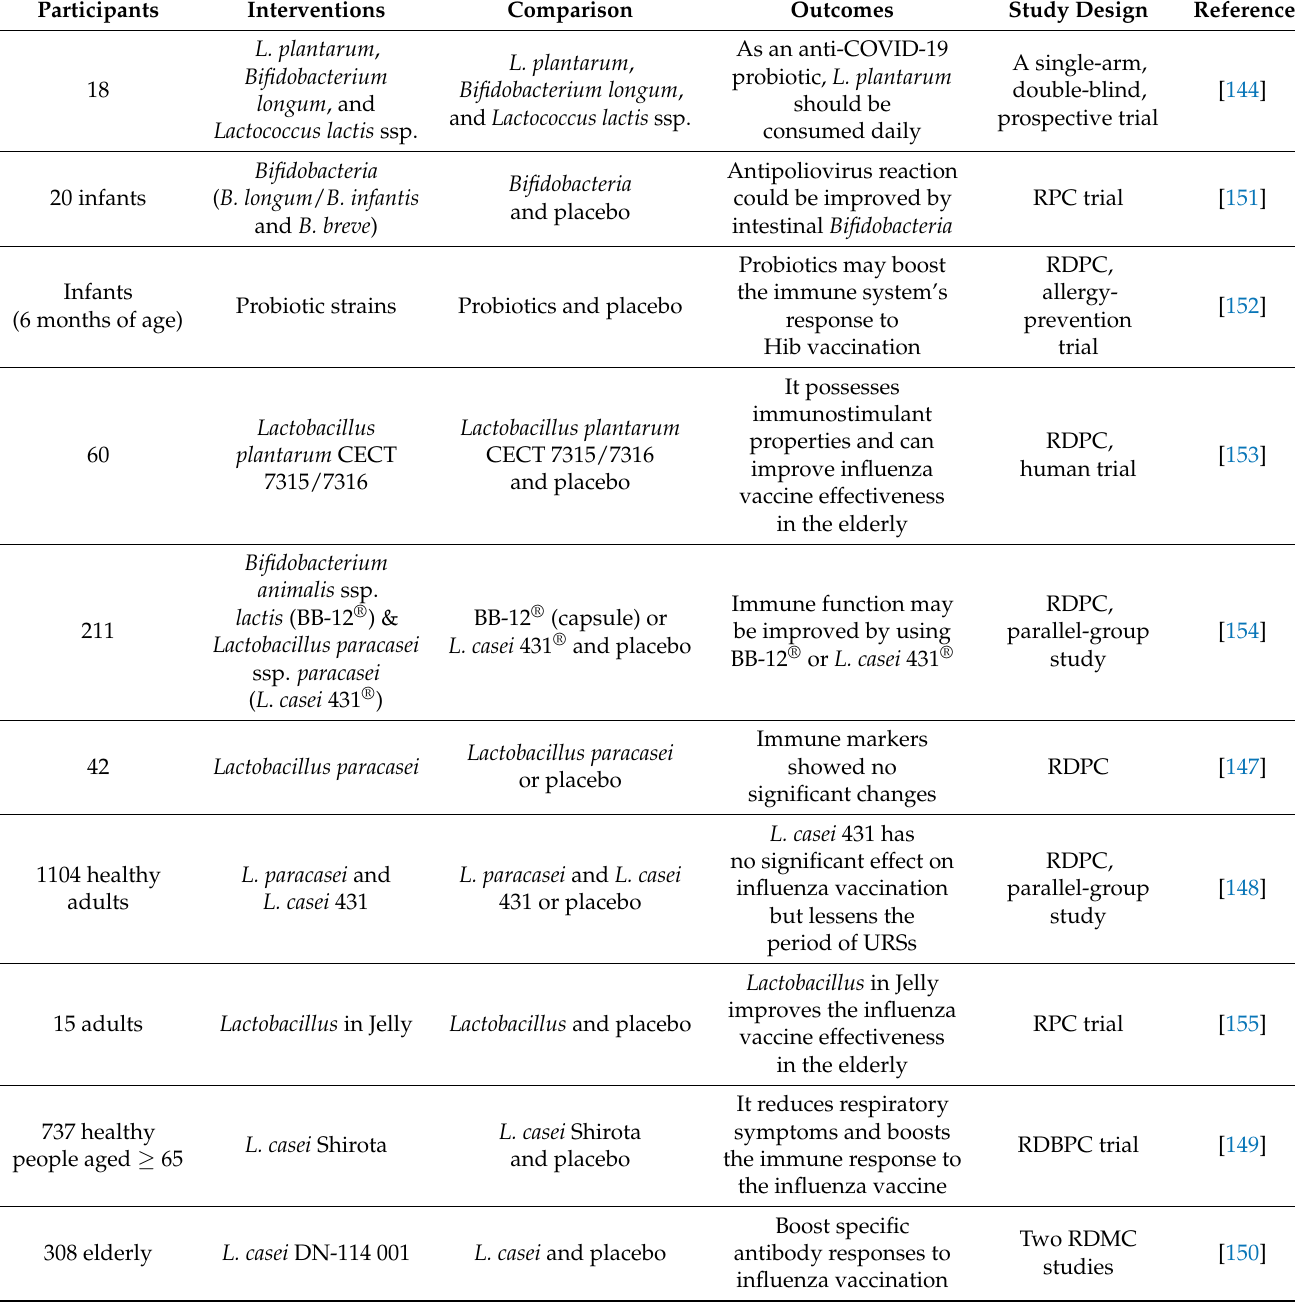
Table 2. The studies enlisting the probiotic efficacy against viral